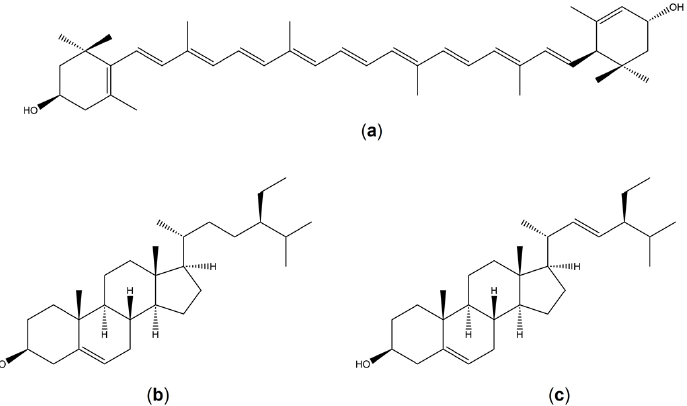
Figure 1. The chemical structures the bioactive compounds isolated from F3: ( a ) lutein; ( b ) β -sitosterol and ( c ) stigmasterol .